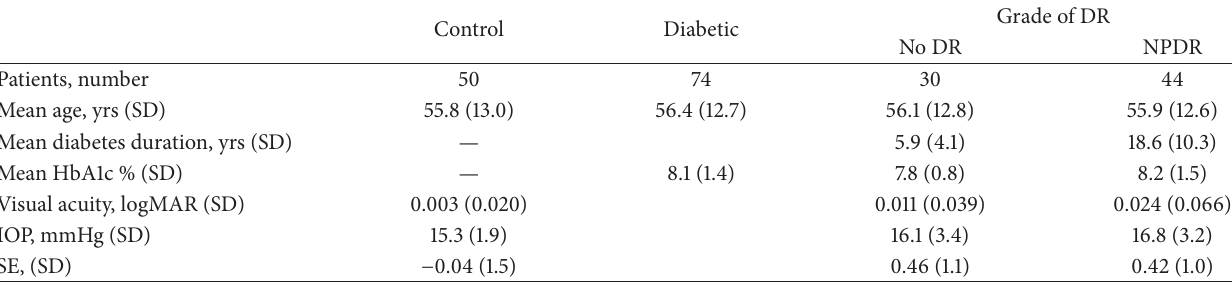
Table 1: Demographic characteristics of the